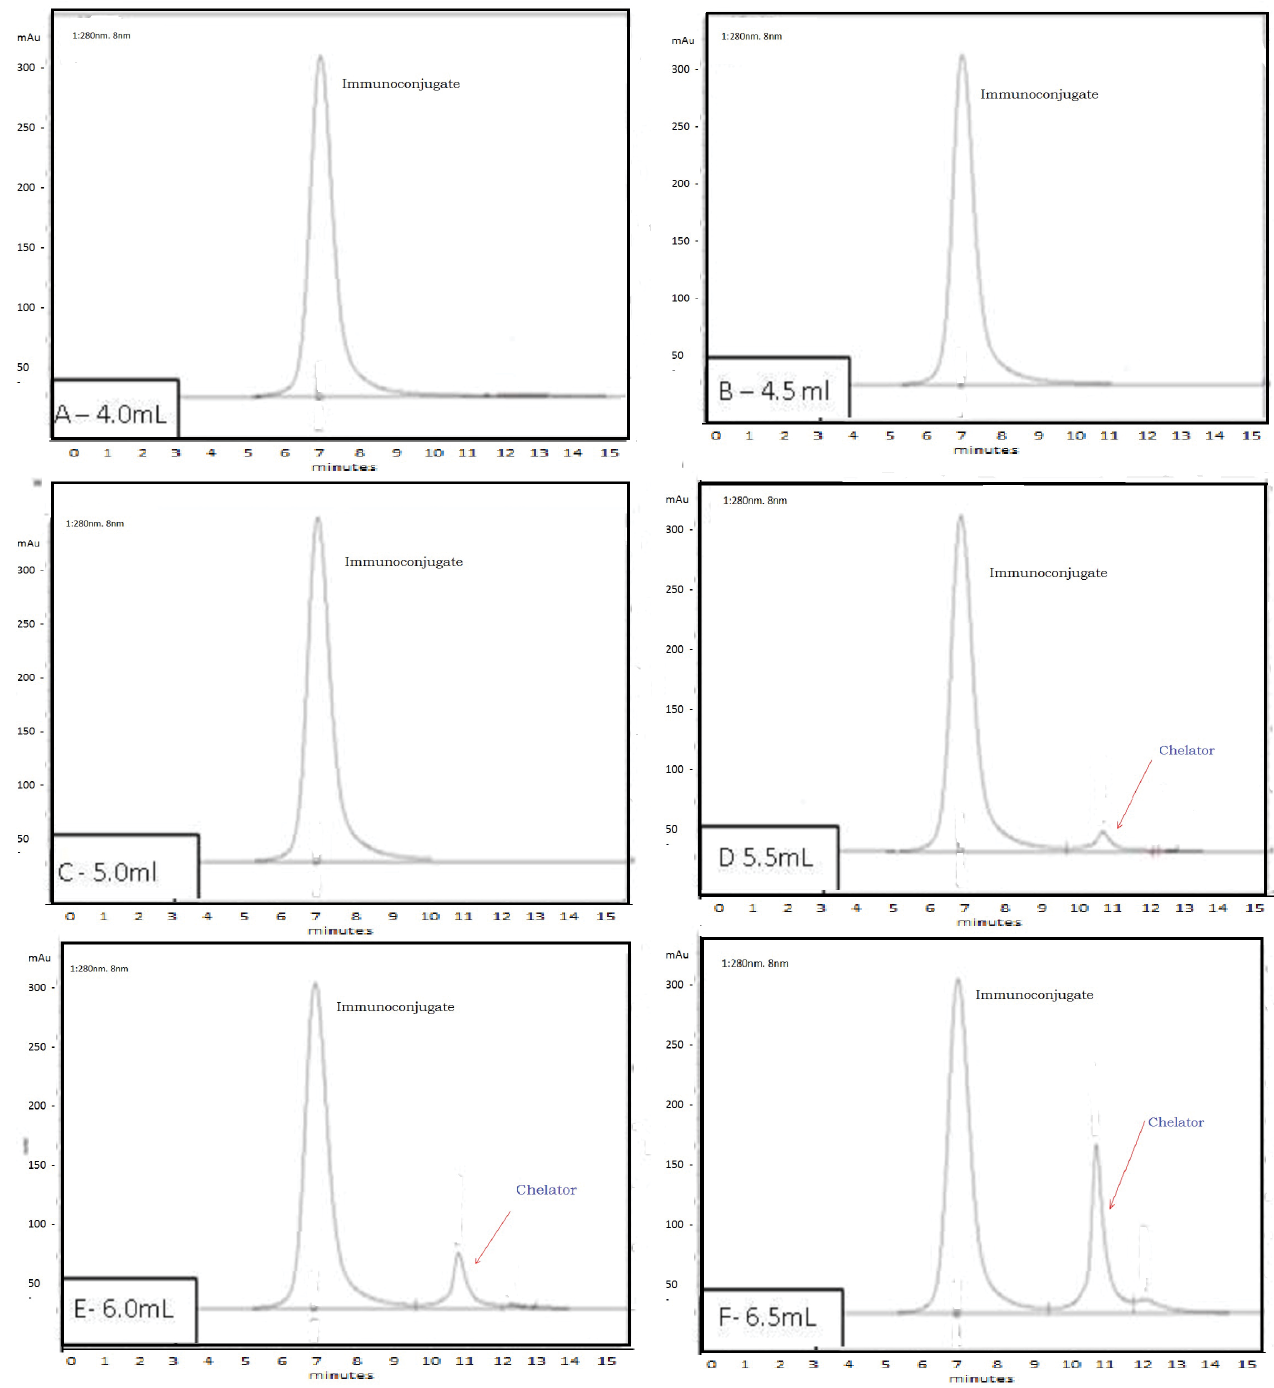
FIGURE 3 - HPLC Immunoconjugate chromatographic profile (UV, 280 nm) after the purification process through size exclusion column (PD10), using 0.25 M ammonium acetate buffer pH 6.5 as eluent. A (4.0 mL) - C (5.0 mL): the peak corresponds to the conjugated antibody; D (5.5 mL) - F (6.5 mL): the peaks correspond to the conjugated antibody and free chelator, retention time (RT) approximately 11